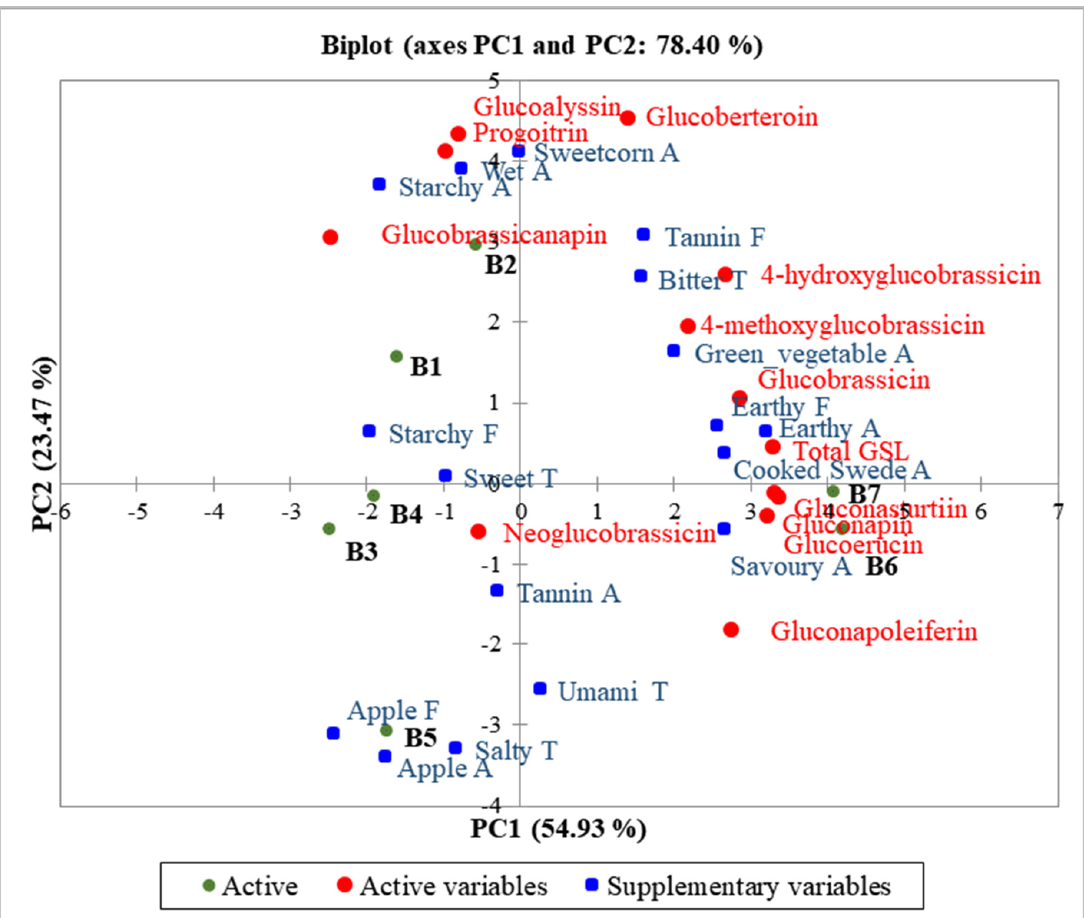
Figure 2. PCA biplot of glucosinolate compounds in 7 batches of steamed-pureed turnip (B1 to B7), with mean ratings of sensory attributes fitted onto the plot as supplementary variables. Abbreviations: A, aroma; T, taste; F, flavour.